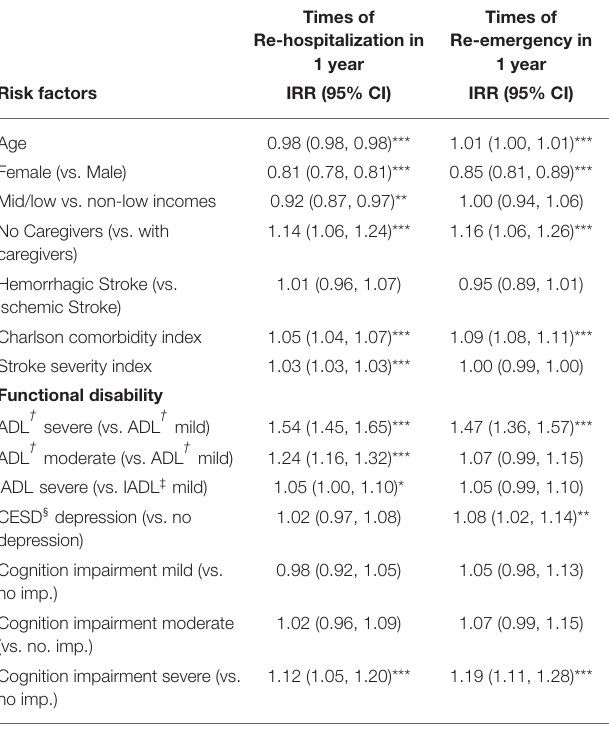
TABLE 4 | Estimates of incidence rate ratio (IRR) with 95% CI for risk factors of 1-year outcomes (rehospitalization, re-emergency) among the LTC recipients with stroke based on negative binomial